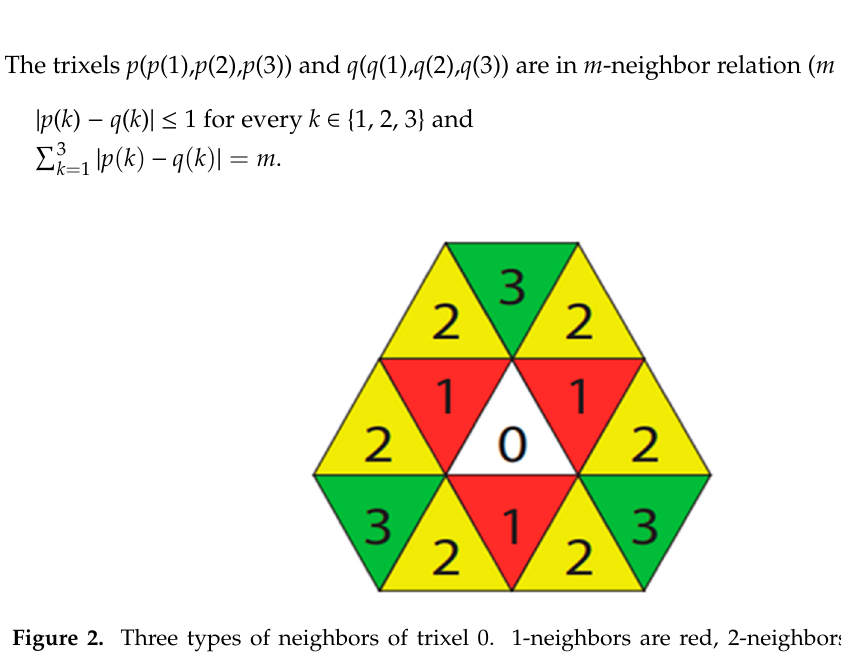
Figure 2. Three types of neighbors of trixel 0. 1-neighbors are red, 2-neighbors are yellow and 3-neighbors are green.